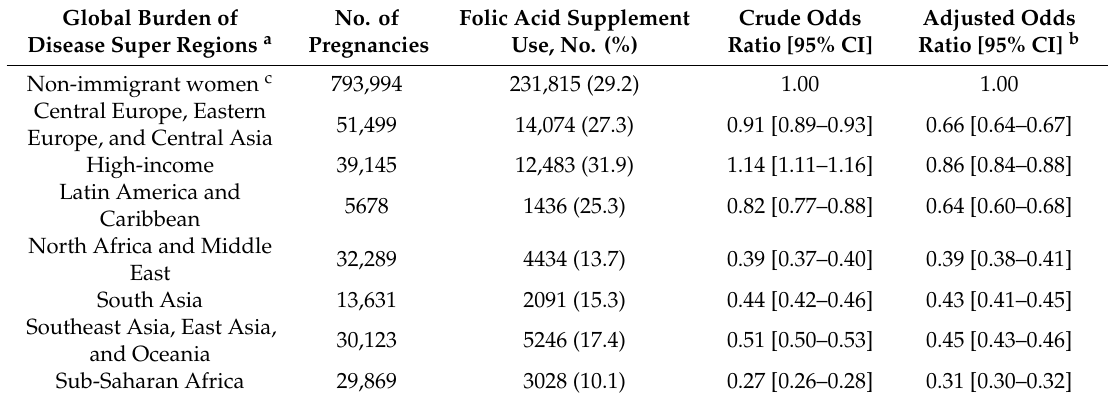
Figure 1. Preconception folic acid supplement use by maternal immigration category (1999–2016). Numbers, percentages and odds ratios for preconception folic acid supplement use are shown in Table S1. Non-immigrant women: Norwegian-born women with two Norwegian-born parents; 2nd generation immigrant women: Norwegian-born women with two foreign-born parents; 1st generation immigrant women: Foreign-born women with two foreign-born parents. Table 2. Percentages and odds ratios for preconception folic acid supplement use in 1st generation immigrant women according to seven Global Burden of Disease super regions